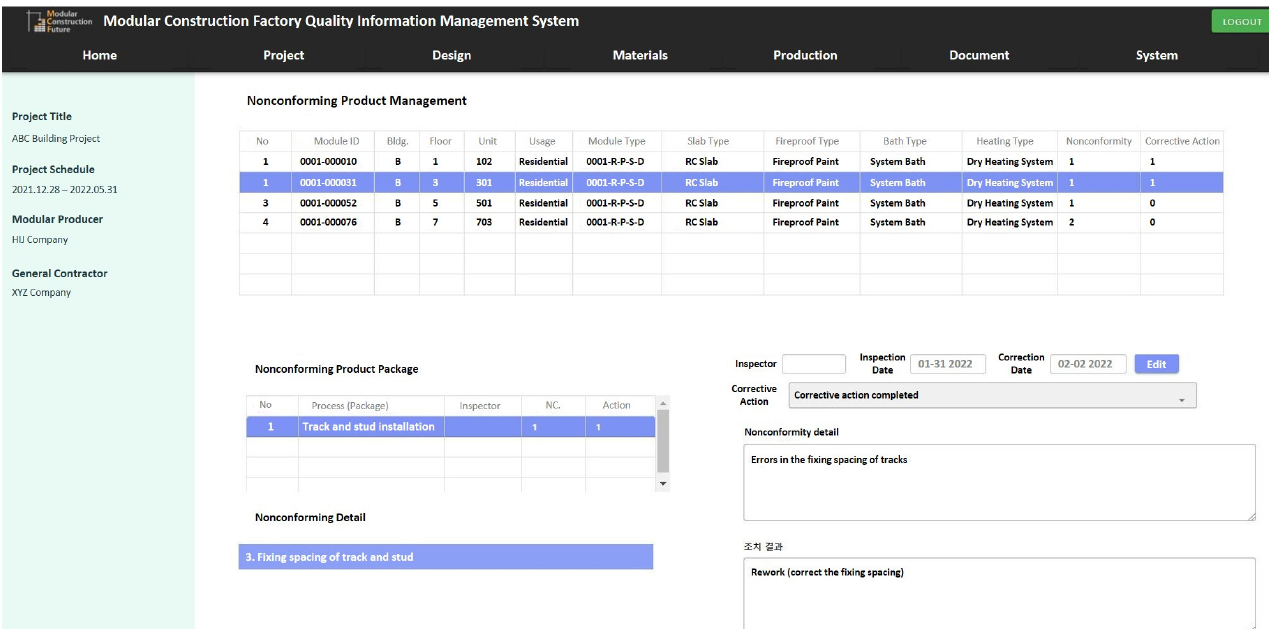
Figure 9. Management of nonconforming module information.